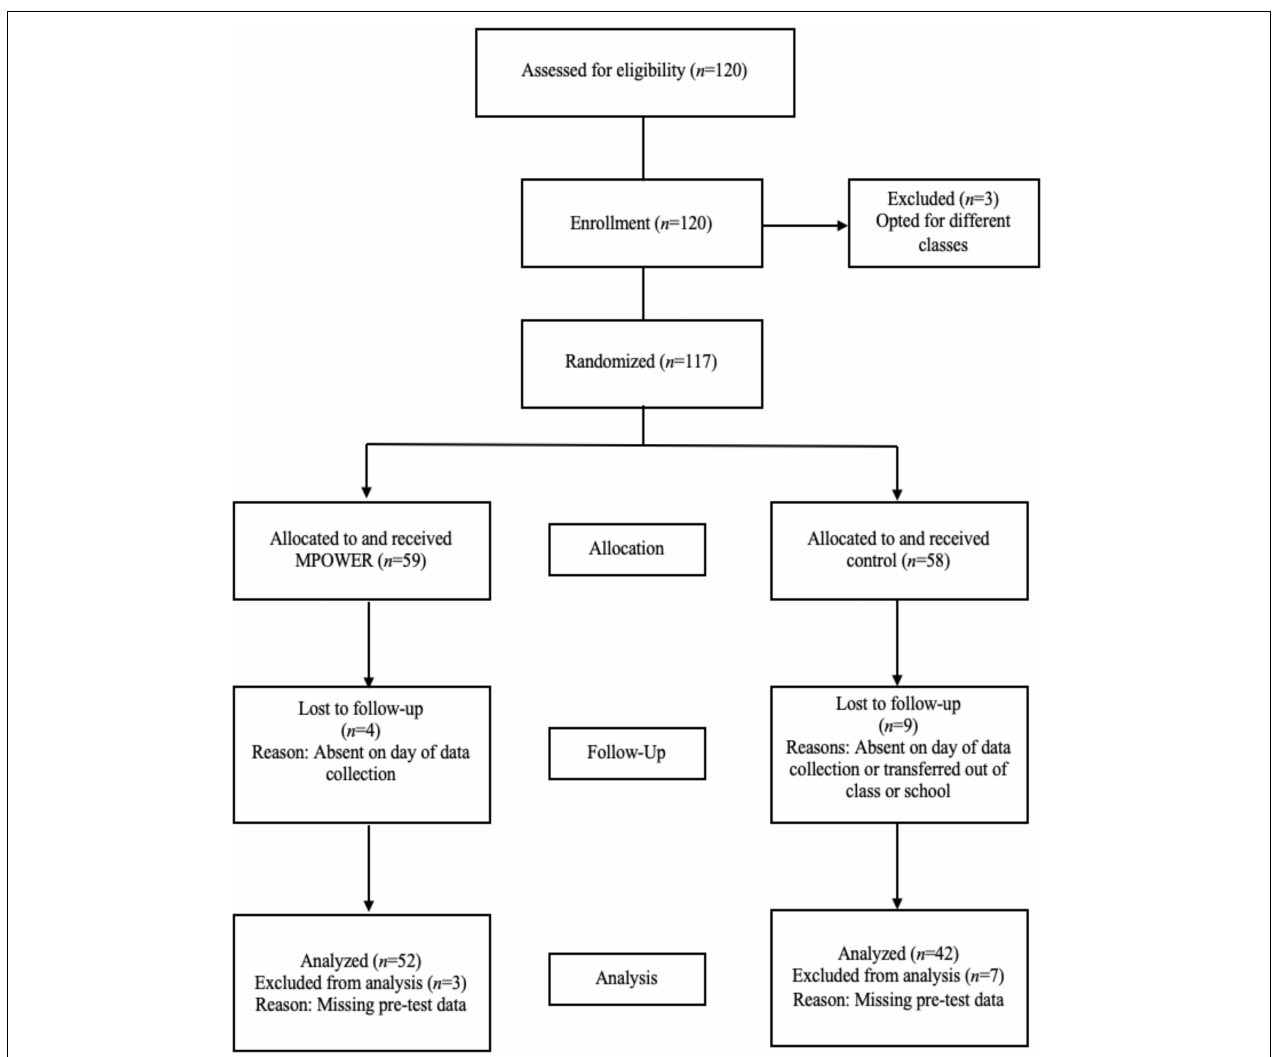
FIGURE 1 | Flow of participants through each stage of the randomized controlled